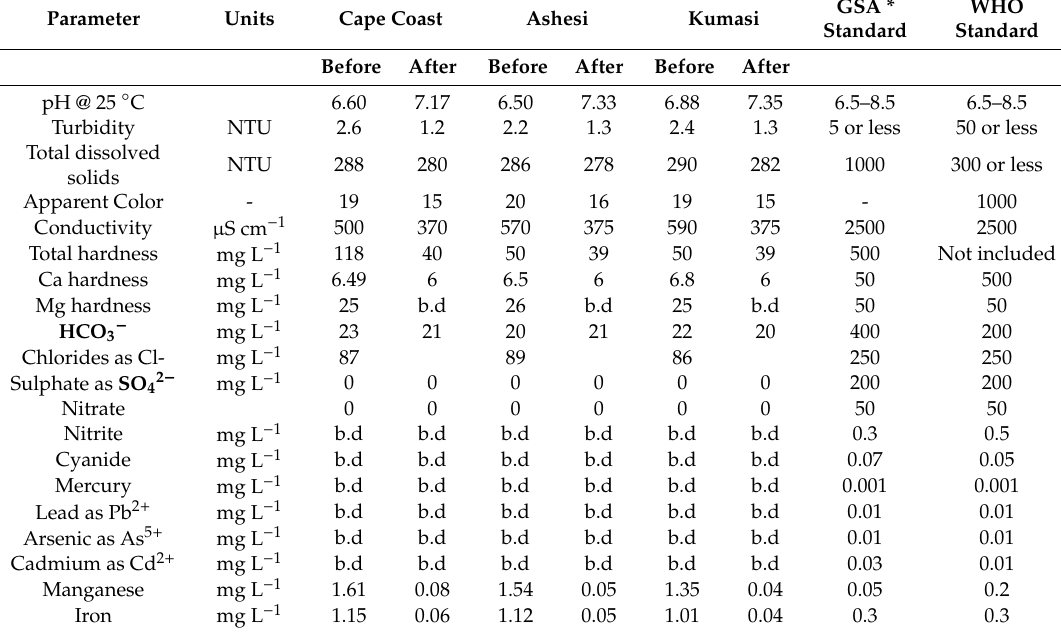
Table 2. Characterized raw water samples from Cape Coast, Ashesi and Kumasi after treatment with zeolite